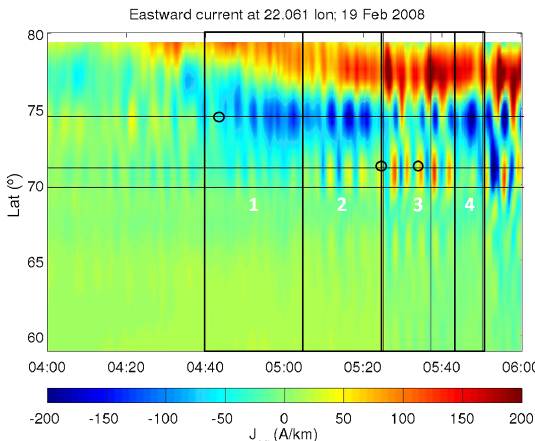
Figure 5. Eastward equivalent currents along the geographic merid- ian 22.1 ◦ E during 04:00–06:00UT on 19 February 2008. (The ver- tical axis is in geographical latitudes.) The four periods with dif- ferent characteristics in 2-D equivalent current patterns are marked with black boundaries and white numbering. The geographic lati- tudes of stations BJN, NOR, and KEV are marked with the black horizontal lines. The auroral breakups at midnight sector took place at the end of Period 2 and at 05:37 (thin black vertical line). The time instants of the 2-D equivalent current maps of Fig. 8 are shown with the black